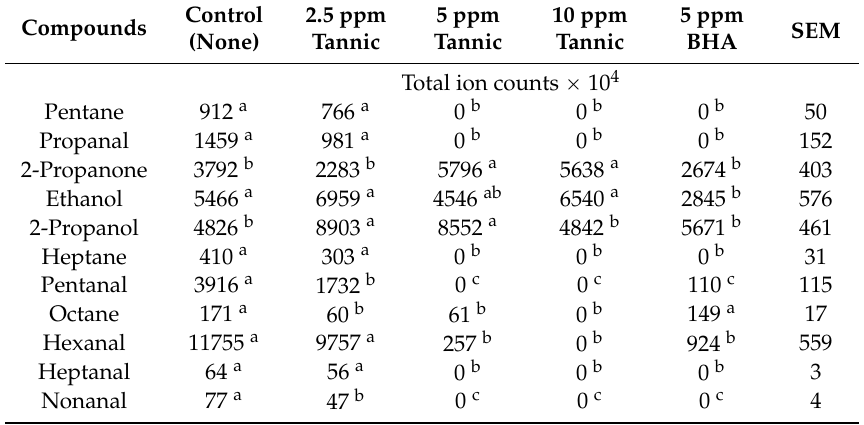
Table 5. Volatile profiles of cooked chicken breast meat with different levels of tannic acid at day 3.